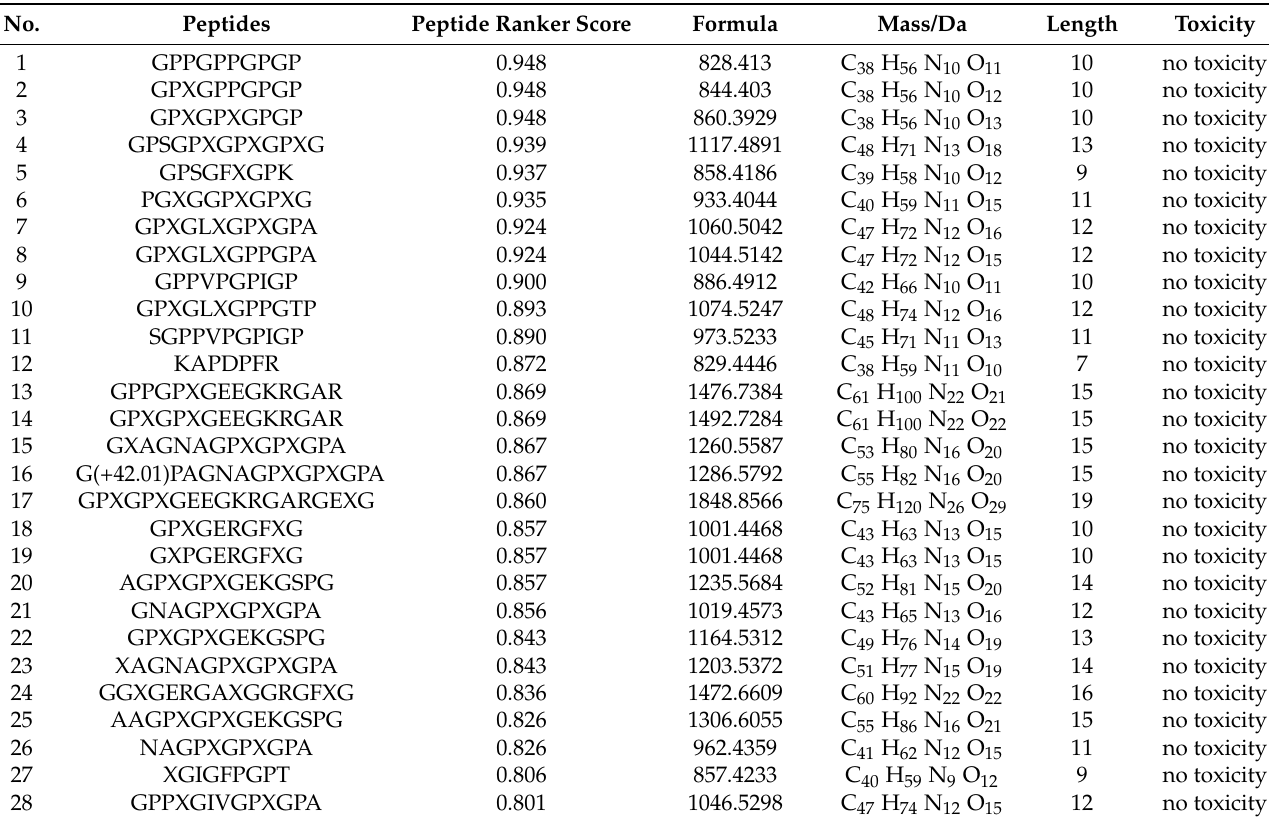
Table 5. The potential bioactive peptides obtained based on Peptide Ranker (>0.80) and Toxin- Pred Website.